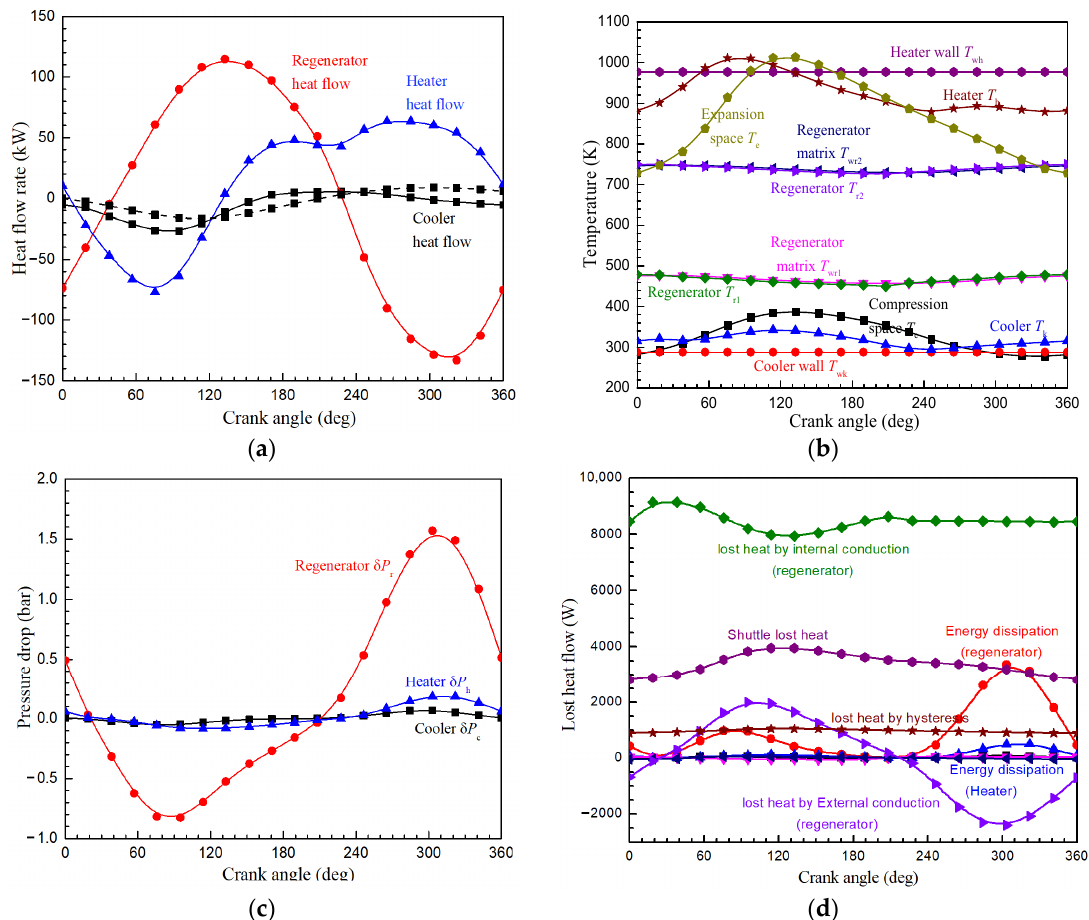
Figure 7. Result of the LQSFM model for the GPU-3: ( a ) the heat flow rate, ( b ) the temperature, ( c ) the pressure drop, ( d ) the heat loss